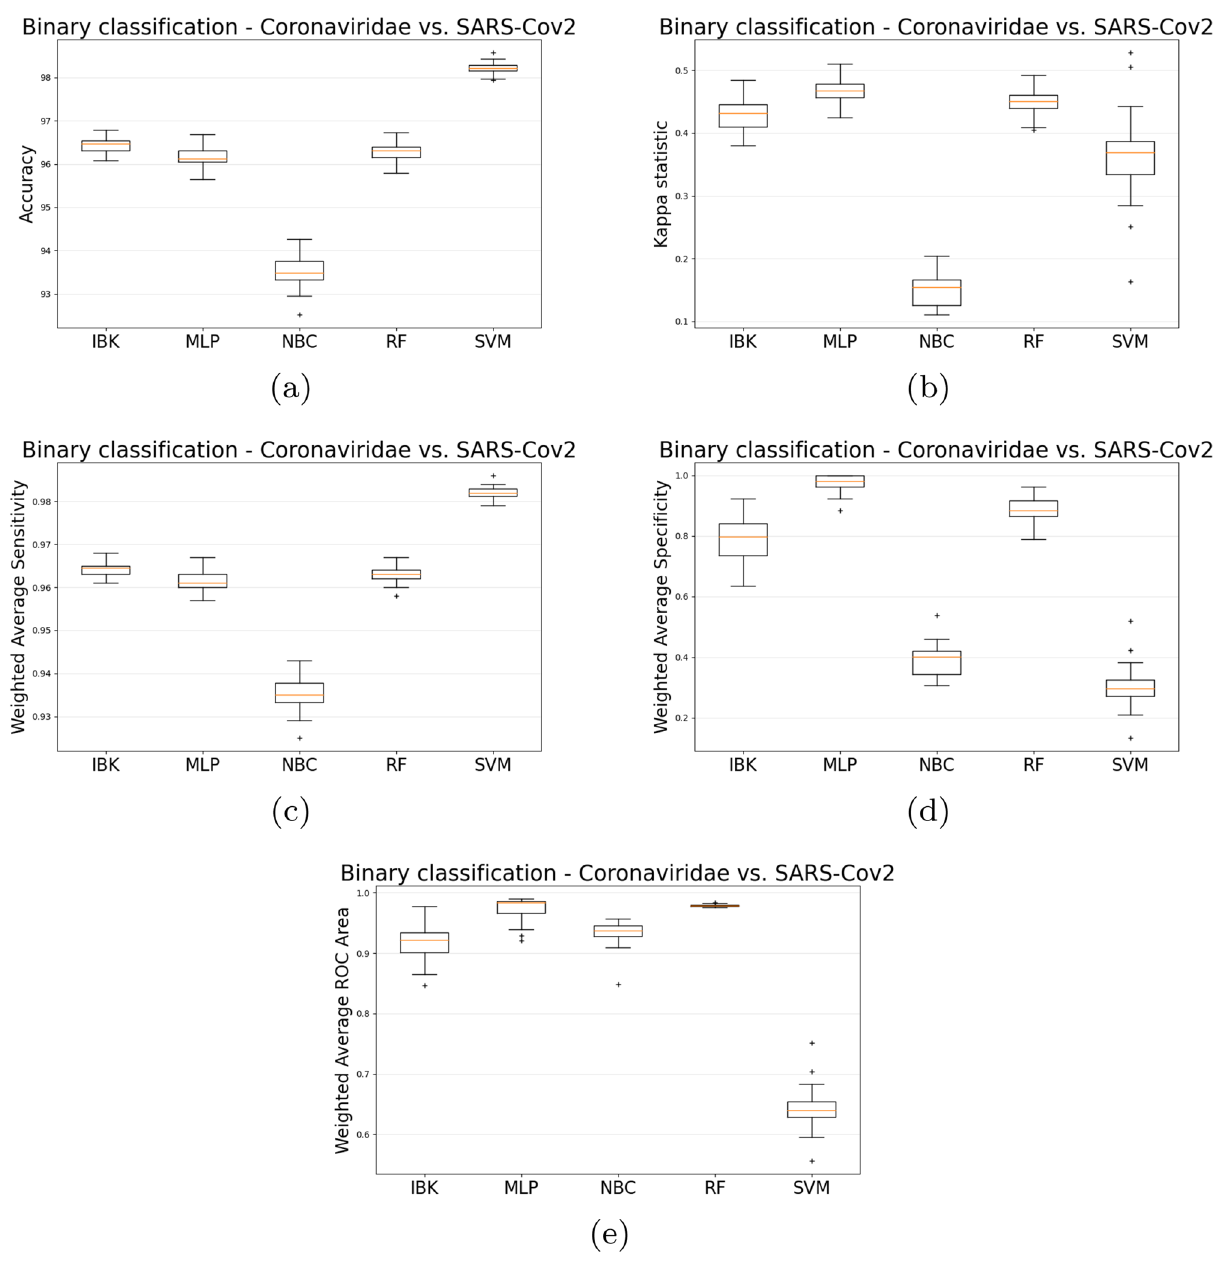
Figure 10. Binary classification (Coronavuris vs. SARS-CoV-2 using the 30% overlap dataset) accuracy ( a ), kappa ( b ), weighed average sensitivity ( c ), specificity ( d ), and ROC area ( e